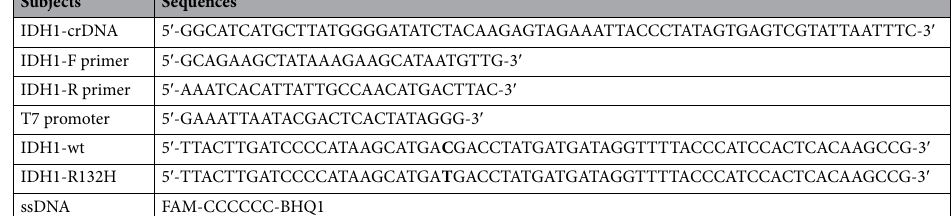
Table 2. crDNA, upsteam and downsteam primer, IDH1-wt and IDH1-R132H sequences.